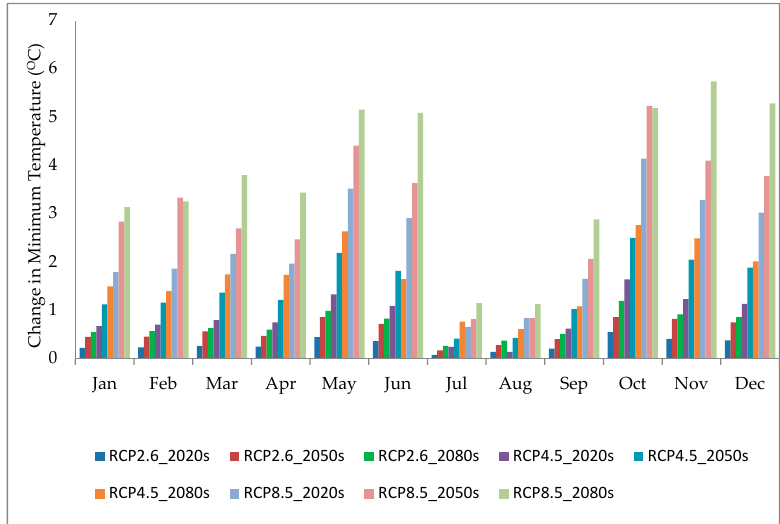
Figure 12. Change in monthly average maximum temperature compared to the baseline period (1961–1990).